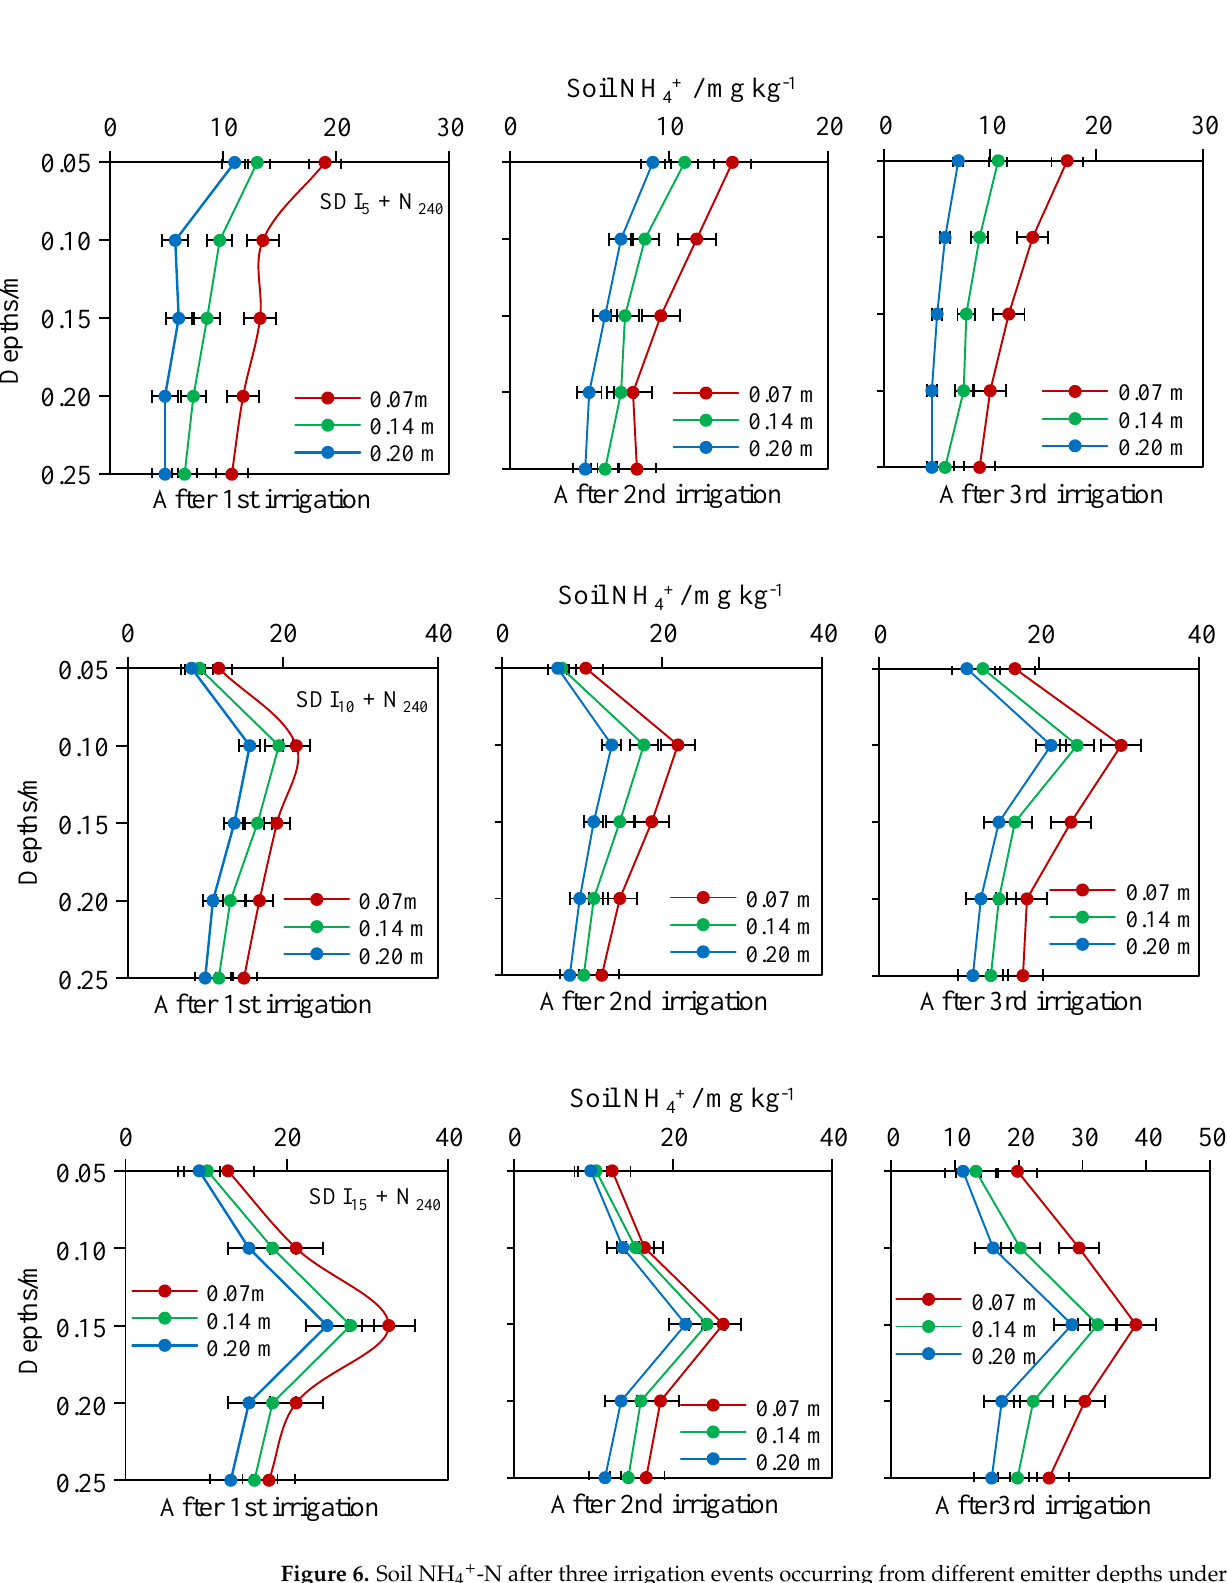
Figure 6. Soil NH 4+ -N after three irrigation events occurring from different emitter depths under the 240 kg N ha −1 fertilization rate. Error bars represent standard error.